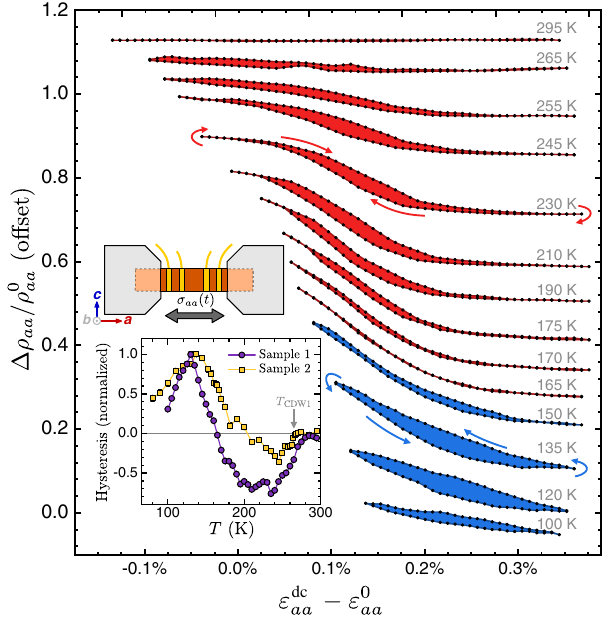
FIG. 7. Ratiometric change in ρ of ErTe 3 through stress aa cycles performed at a few representative temperatures. Curves are offset vertically for clarity. Inset: schematic of the contact and stress geometry, and plot of the integrated area contained within the hysteresis loops in (b) for two different samples of ErTe 3 . In both, the hysteresis loops open as the sample cools through T . The hysteresis loop changes direction (clockwise to CDW 1 counterclockwise) as the temperature decreases further. The extracted area is sensitive to the exact dc strain range accessed, which accounts for the differences between samples. The observed hysteresis clearly indicates the first-order nature of the phase transition where the direction of the CDW wave vector switches from q a to q c , corresponding to the schematic phase diagram shown in Fig.